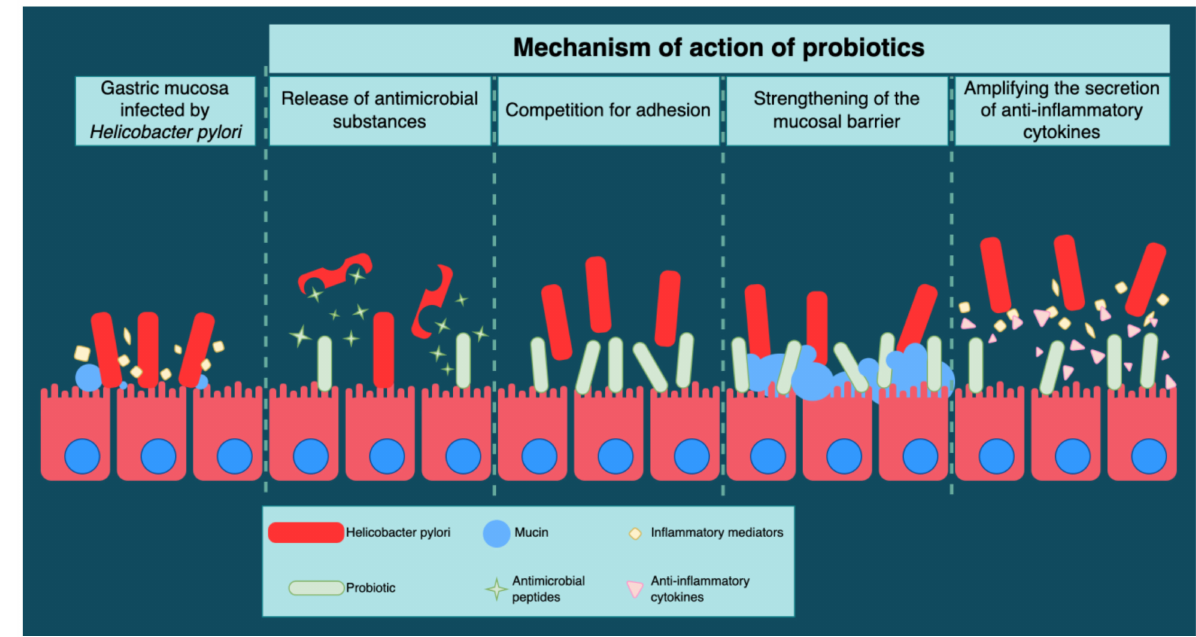
Figure 4. Probiotics’ mechanism of action in H. pylori